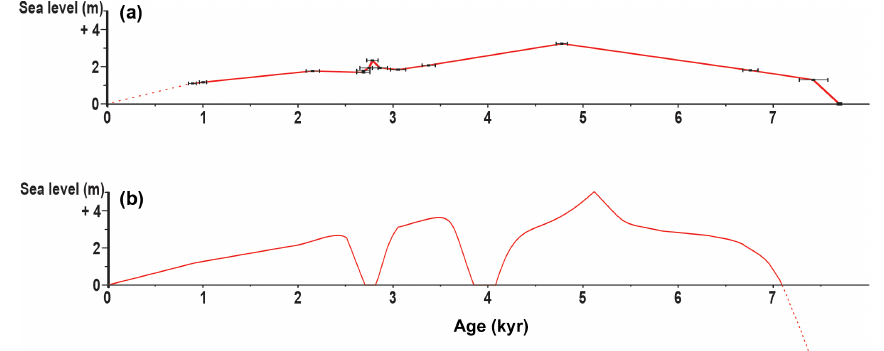
Figure 5. Relative sea-level variation curve for (a) the coast of the Rio de Janeiro state, Brazil (Castro et al., 2014), and (b) Salvador, Bahia state, Brazil (Martin and Suguio,